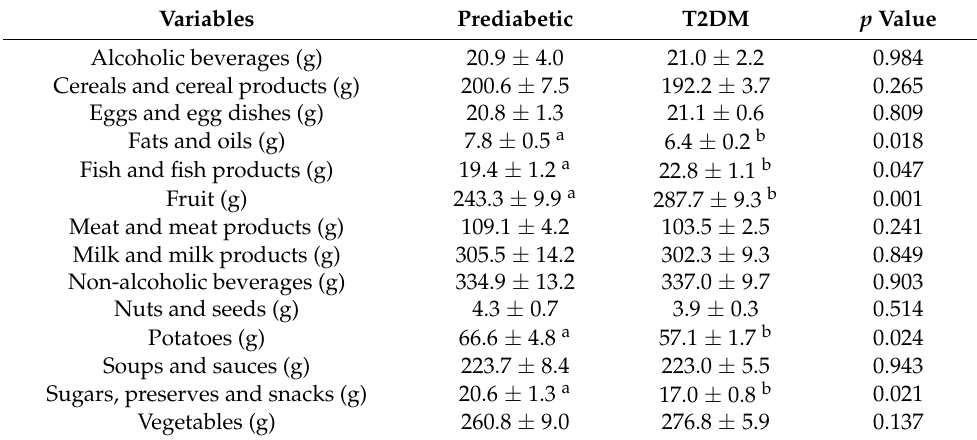
Table 2. Food group intake of study participants.